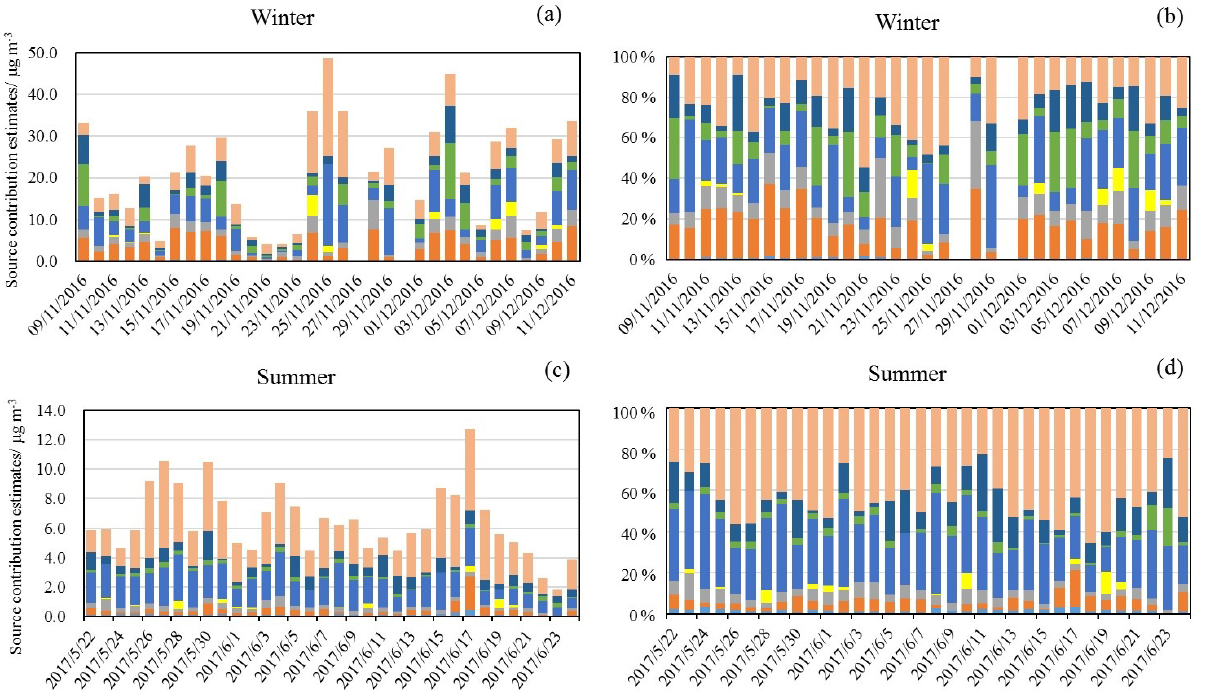
Figure 4. Daily source contribution estimates for fine OC in (a) winter and (c) summer and their relative abundance in winter (b) and summer (d) .